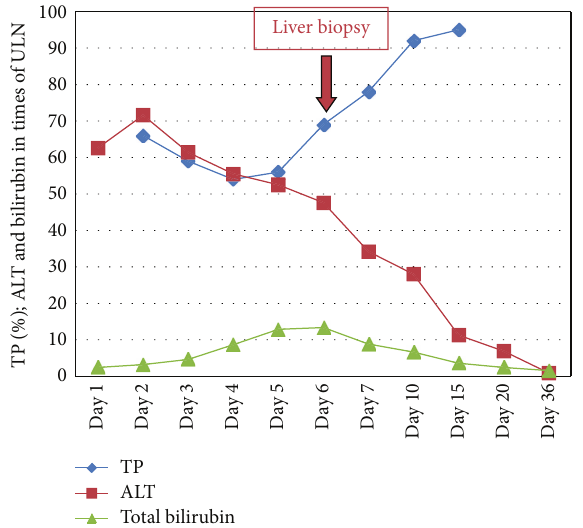
Figure 3: Liver function test evolution: day 1: January 24, 2013 and ULN: upper limit of